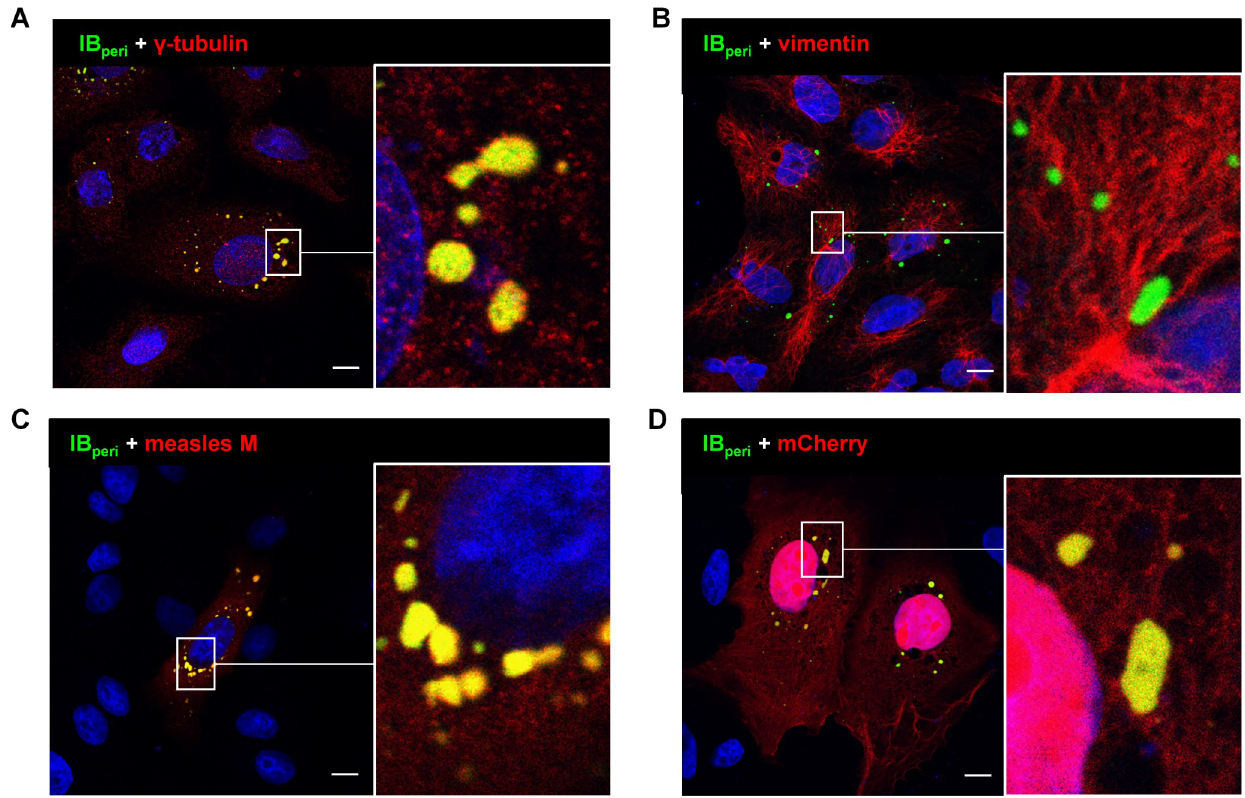
Fig 7. Colocalization of NiV IB peri with cellular aggresome markers and unrelated cytosolic proteins. (A, B) Vero76 cells were transfected with NiV N and NiV P eGFP to form IBs (IB peri ). At 24 h p.t. cells were fixed with 4% PFA and permeabilized with methanol/acetone. IBs were detected by P eGFP autofluorescence (IB peri ). Cellular aggresome markers ( γ -tubulin and vimentin) were detected with specific antibodies (red). (C, D) NiV N and NiV P eGFP were coexpressed with non-related cytosolic proteins (red). Measles virus matrix protein (measles M) was detected with a specific monoclonal antibody (C) and reporter mCherry was detected by autofluorescence (D). Nuclei were counterstained with DAPI (blue). Only merged confocal images are shown. IBs within the boxed areas are shown in higher magnification. Scale Bars, 10 μ m.